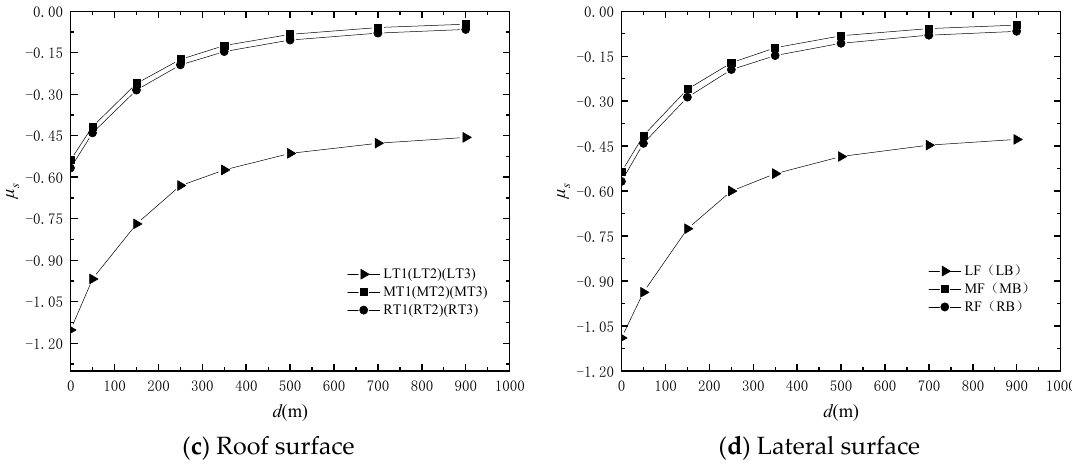
Figure 15. Wind pressure coefficient in each area of the greenhouse with 90° azimuth.